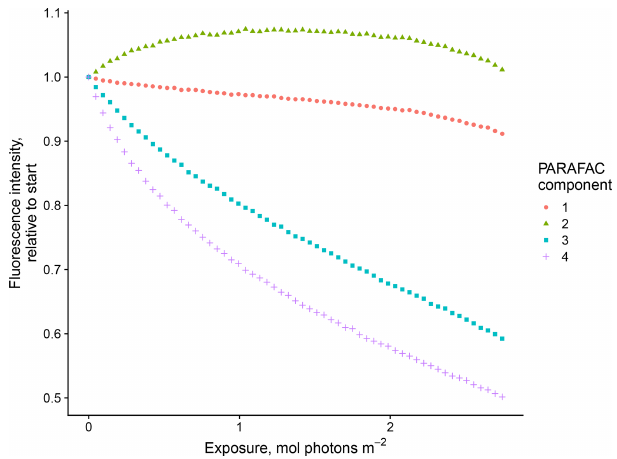
Figure 2. Example of fluorescence change in PARAFAC com- ponents during photodegradation. Data show the degradation of SRNOM